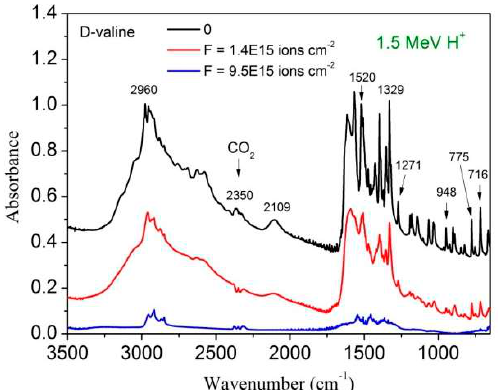
Figure 1. Evolution of the valine infrared spectrum as the projectile fluence increases. The upper spectrum corresponds to the virgin sample; the two others were acquired at fluences 1.4 × 10 15 and 9.5 × 10 15 ions cm − 2 , respectively. The feature at ~2350 cm − 1 is due to atmospheric CO 2 outside the chamber but inside the FTIR spectrometer; its absorbance varies up and down with time.